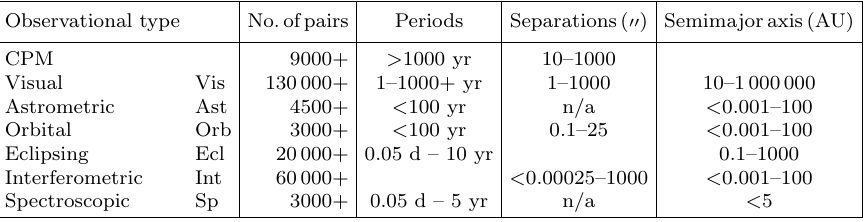
Table 1. Some observational and physical parameters of binaries depending on observational type. Observational type No.ofpairs Periods Separations( ′′ ) Semimajoraxis(AU) CPM 9000+ > 1000